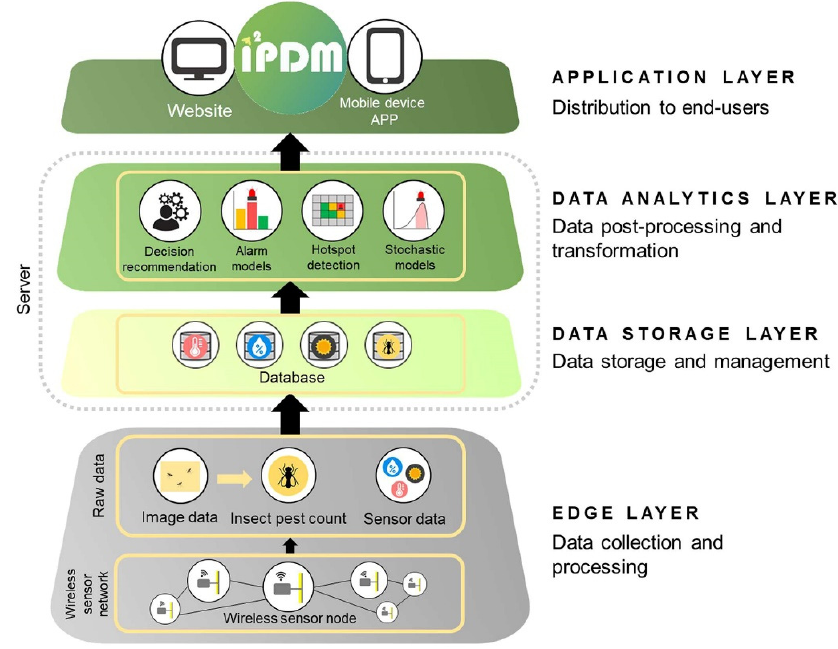
Figure 5. Key attributes of the intelligent IPM system [14].